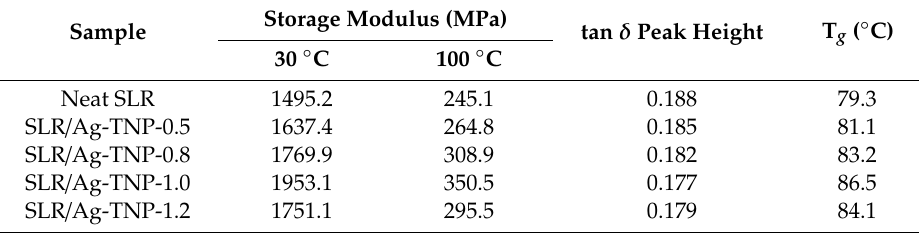
Table 4. The storage modulus and tan δ values of neat SLR and SLR / Ag-TNP nanocomposites.